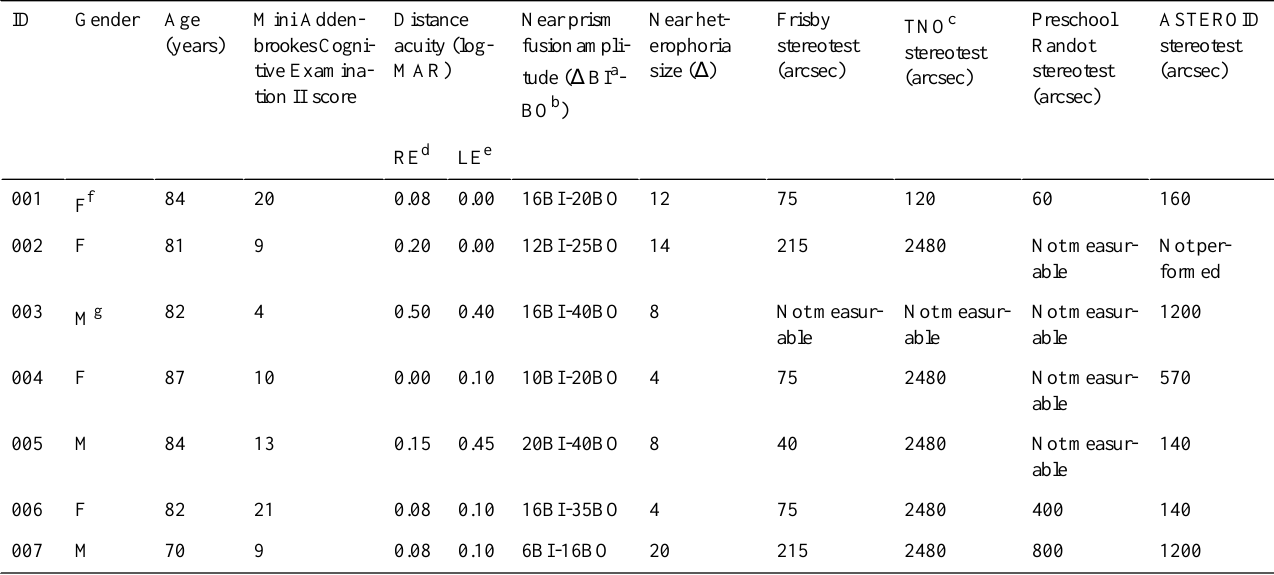
Table 1. Small-sample pilot data trialed multiple stereotests with individuals who had cognitive impairment